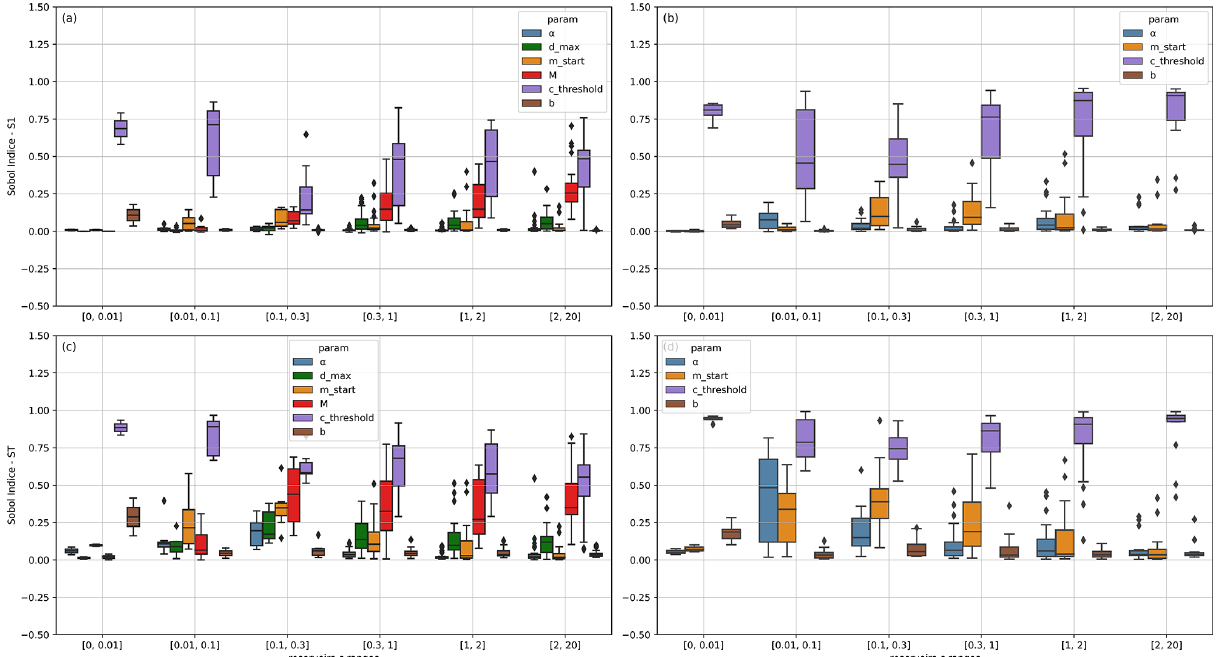
Figure 11. Distribution of first- (“ S 1”) and total-order (“ST”) Sobol indices of parameters according to relative capacity: (a, c) in irrigation and (b, d) in non-irrigation reservoirs.